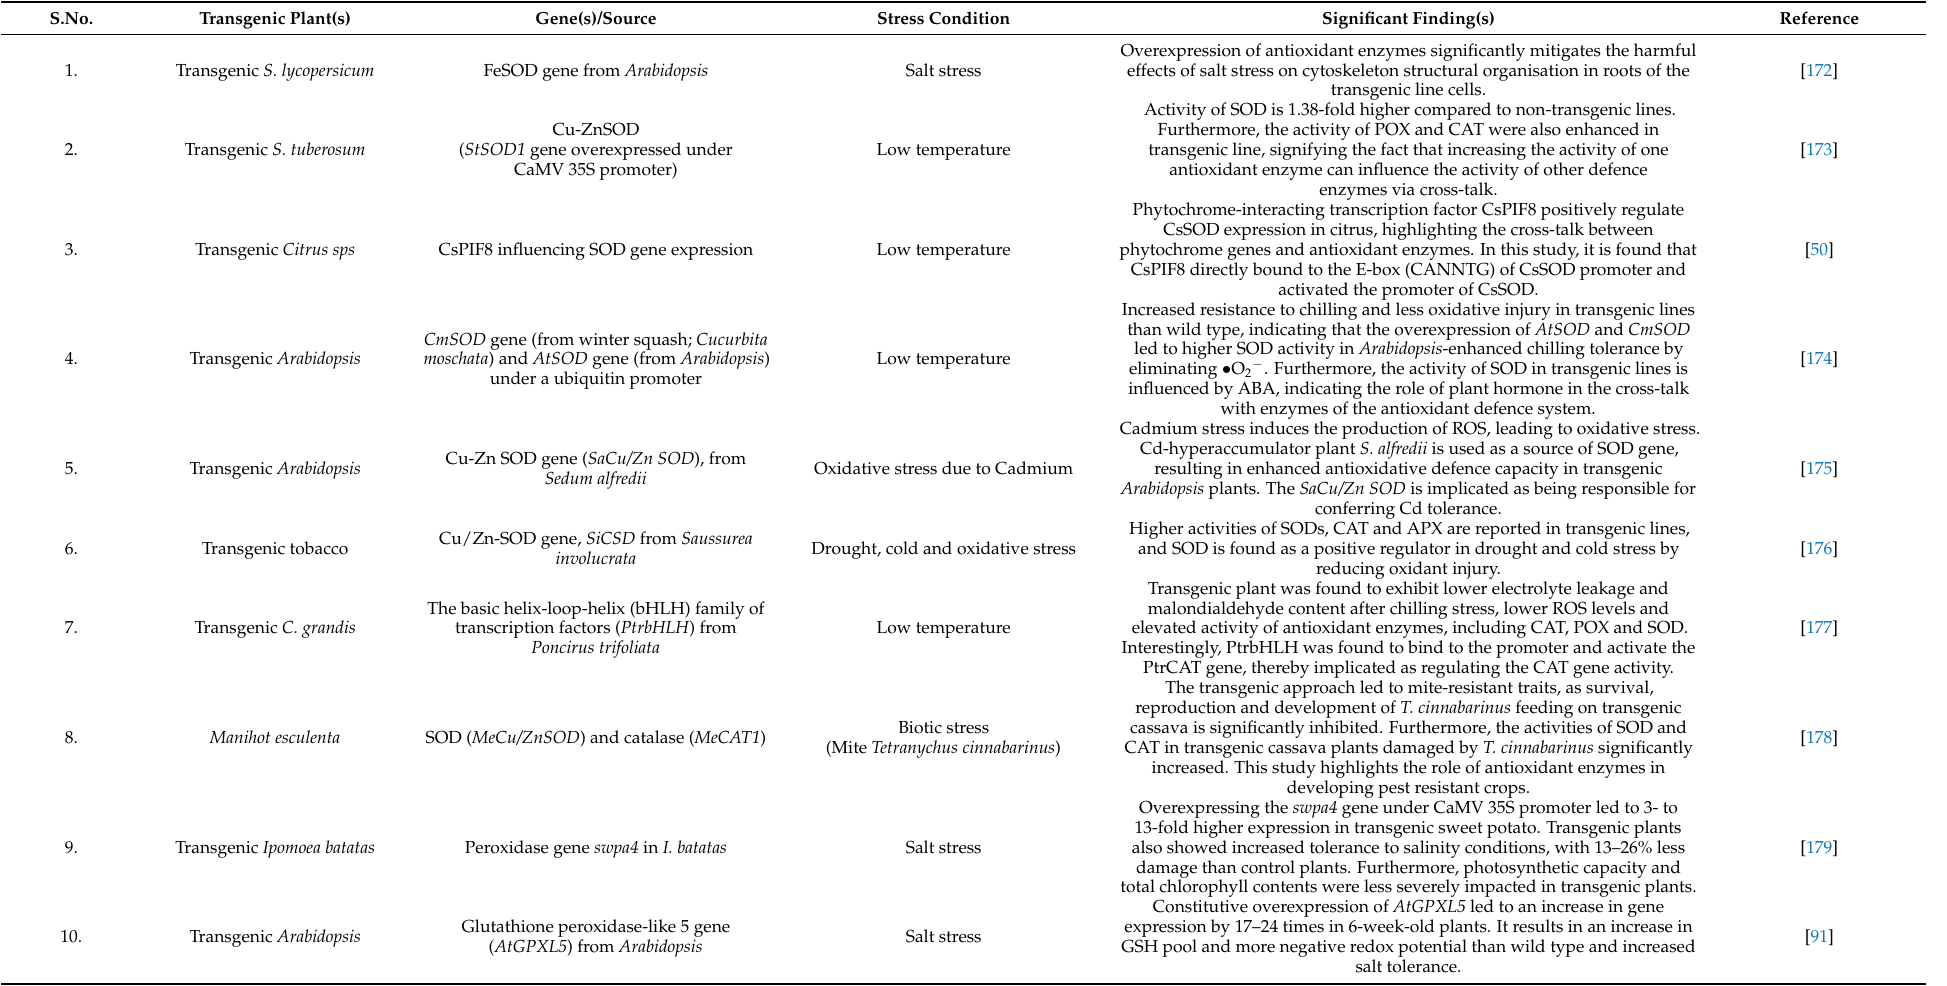
Table 1. Recent studies of transgenic overexpression of different genes encoding antioxidant enzymes in enhancing stress tolerance in transgenic plants along with significant